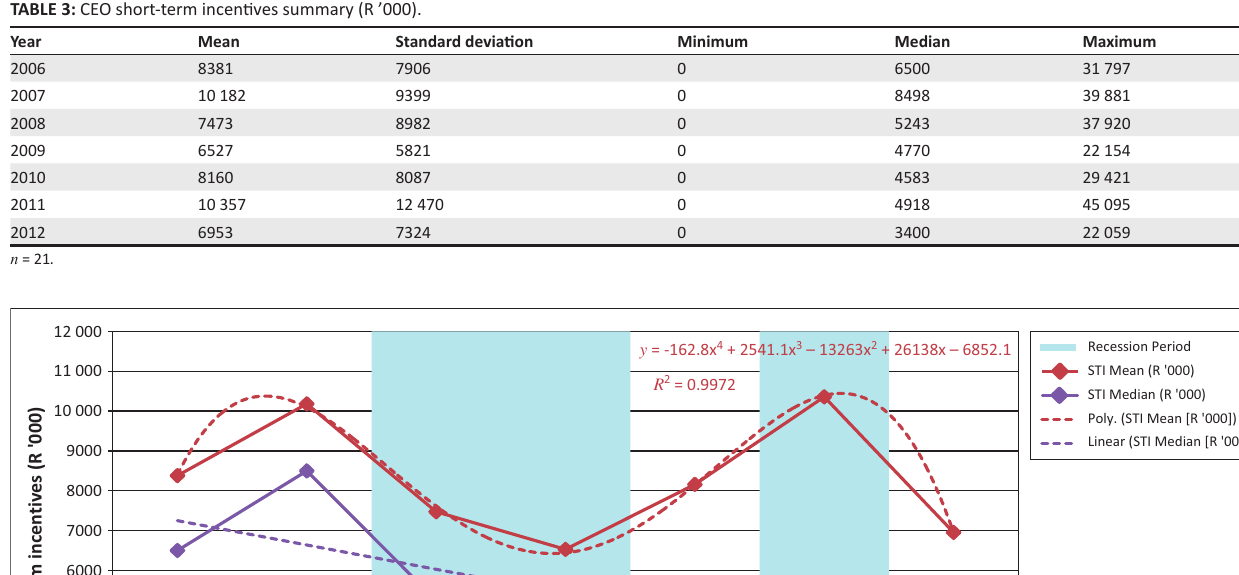
y = 372.25x + 4879.9 R ² =